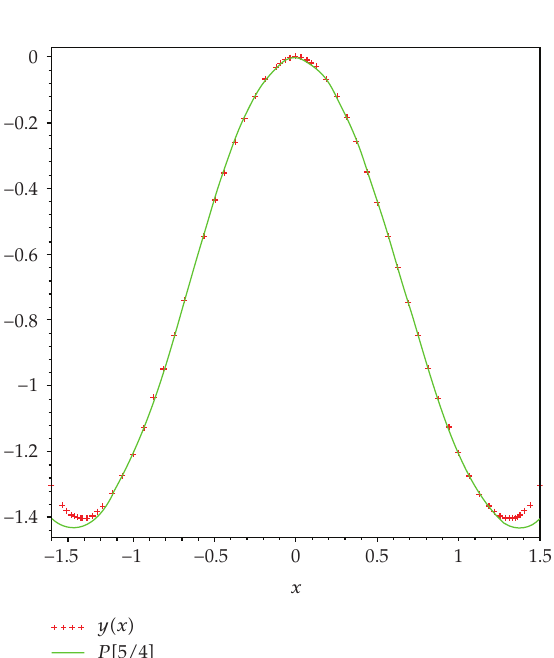
Figure 2: Values of y (cid:7) x (cid:8) and its P (cid:3) 5 / 4 (cid:4) Pad´e